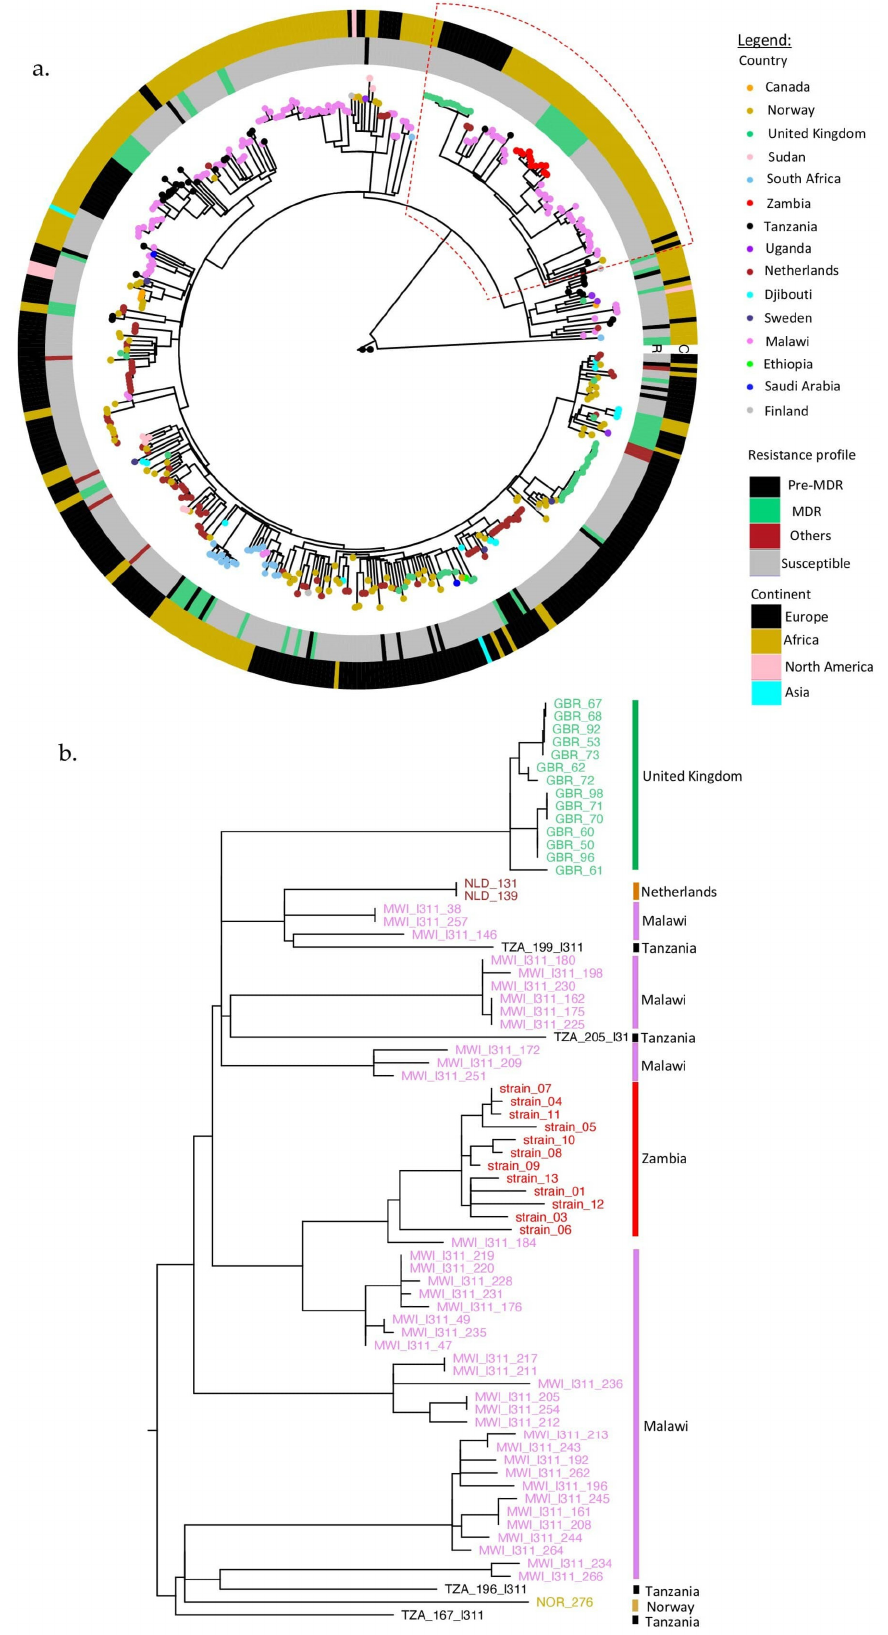
Figure 2. ( a ) Phylogenetic tree for global L3.1.1 strains. The countries are represented by small circles on the tips of the tree and colored as shown in the legend. The inner (R) and outer circles (C)